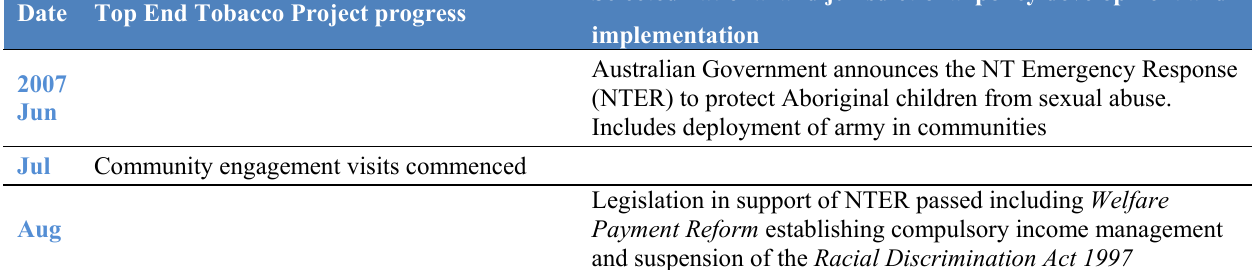
Table 1. Timeline of key milestones of the Top End Tobacco Project aligned with selected national and jurisdictional policies impacting on remote Aboriginal